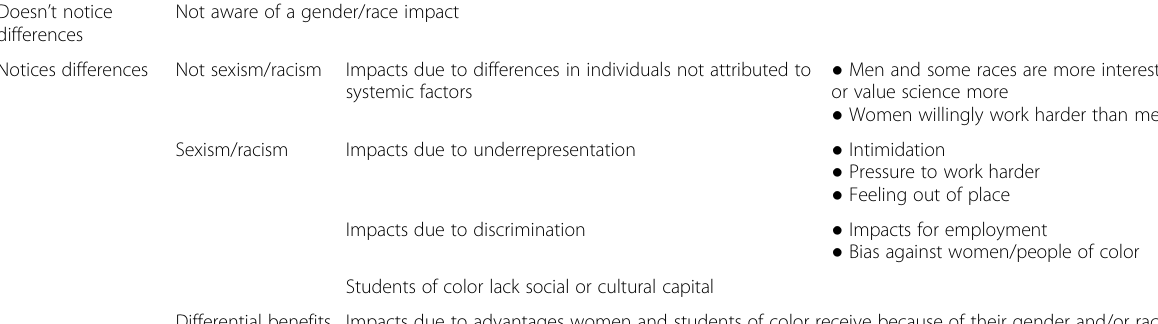
Table 1 Coding scheme for gender and race differences analysis Doesn ’ t notice differences